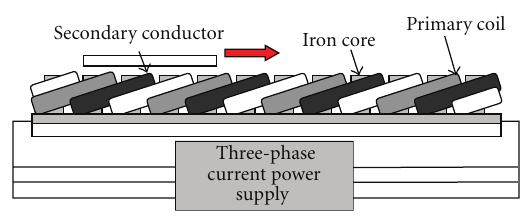
Figure 2: Magnetic rail.